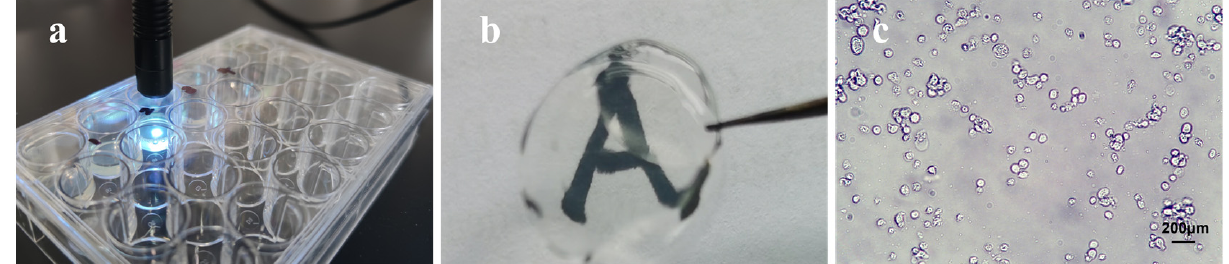
Figure 2. ( a ) GelMA material and 1% elicitor were exposed to UV light for 50 s; ( b ) GelMA solidified after UV irradiation has good transparency; ( c ) Keratocytes were grown in GelMA material.